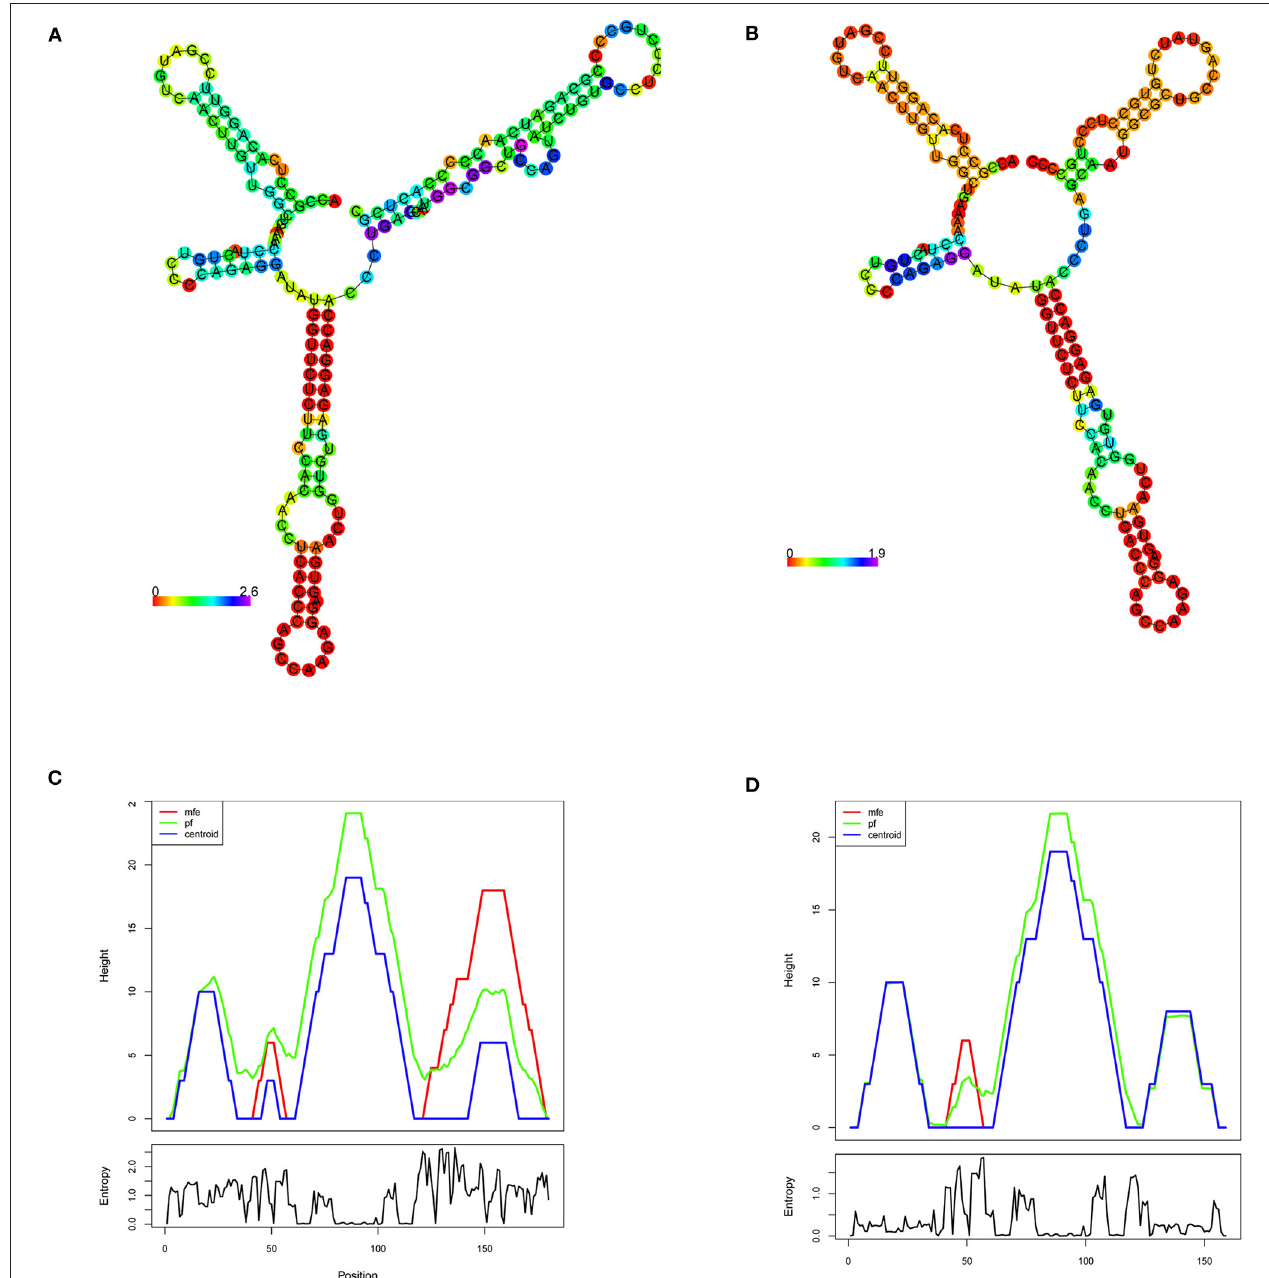
FIGURE 4 | RNA secondary structure prediction of the human LDLR by RNA Fold. (A,B) Shows the LDLR , RNA secondary structure predictions for wildtype and mutant (c.2207delG), respectively, based on minimum free energy (MFE) calculations of nucleotide base pairing, which is represented by color gradient in the scale of 0–2. (C,D) Shows the mountain plot (MP) representation of MFE, thermodynamic ensemble (pf) and the centroid structure predictions, of the LDLR native and mutant (c.2207delG) RNA secondary structures, respectively. MP shows the secondary structures in a height vs. position, where the helices are represented in slopes, loops in plateaus and hairpin loops in the peaks. The bottom graph represents the entropy of predicted RNA structure, where higher the entropy means the RNA structure has lower stability.